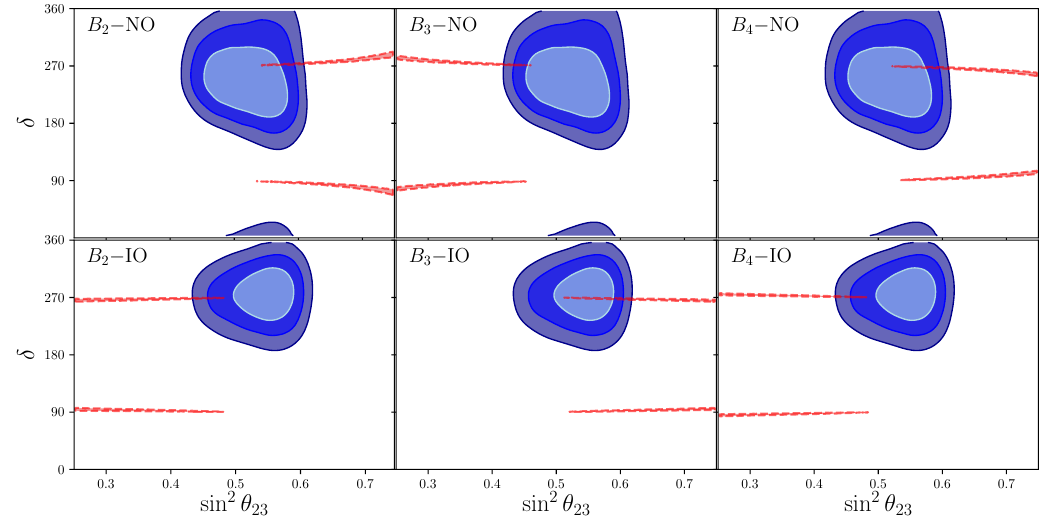
Figure 3 . Same as the left panels of (cid:12)gure 2 for the B 2 , B 3 and B 4 textures. Above for in NO and below for IO.